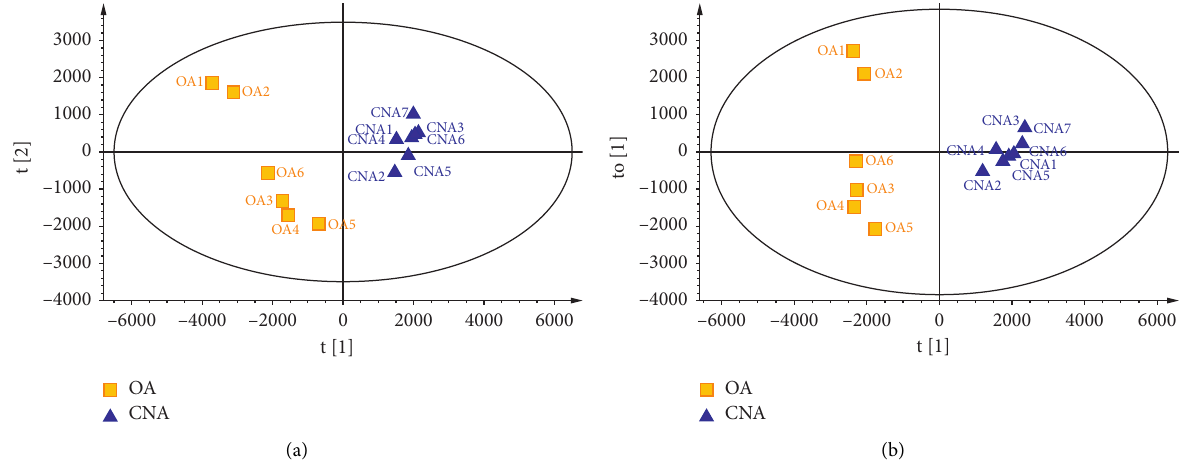
Figure 2: PCA (a) and OPLS-DA (b) scores plots for the first two components of Chi-Nan agarwood (filled triangle)and ordinary agarwood (filled square) data analyzed by